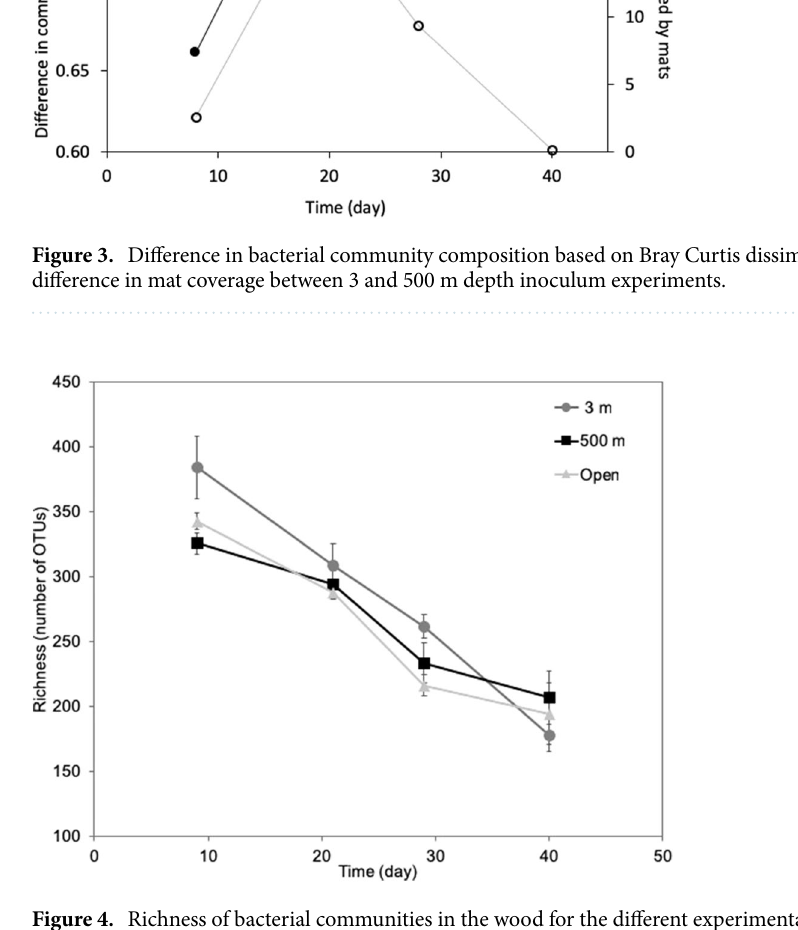
Figure 4. Richness of bacterial communities in the wood for the different experimental conditions and at different times of